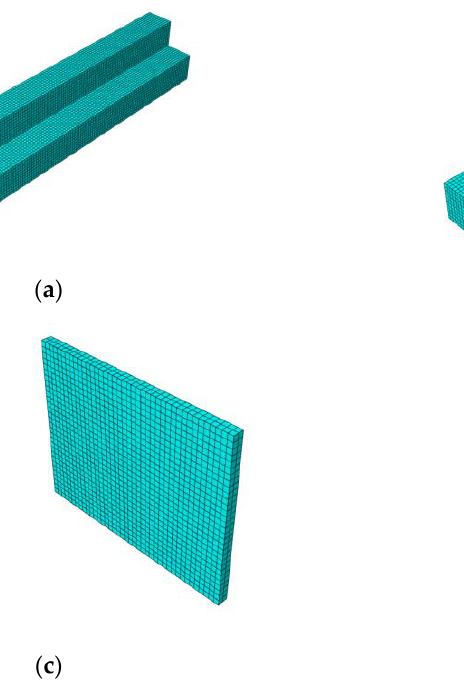
Figure 9. Finite element (FE) model: ( a ) Multi-cavity steel tube component; ( b ) Concrete component; ( c ) End plate component; ( d ) Entire FE model. ( c ) End plate component; ( d ) Entire FE